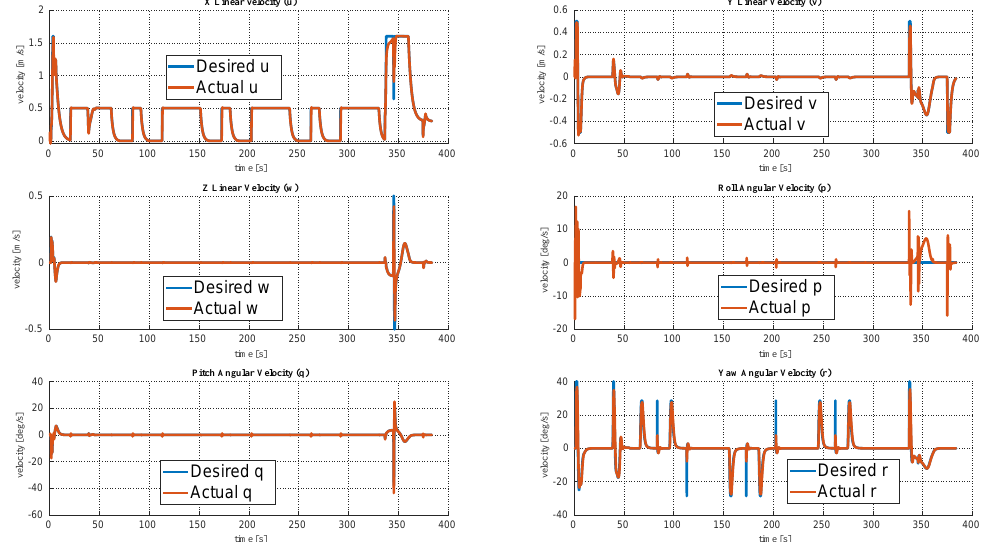
Figure 15. Constant depth mission: Plot depicting the time behavior of desired velocities and the actual/system velocities of the